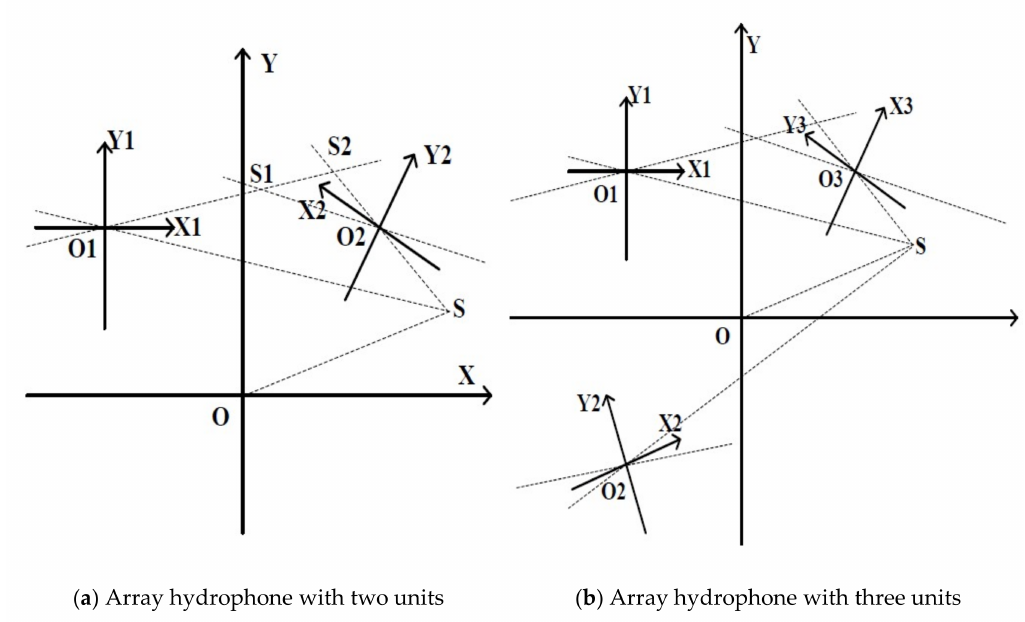
Figure 4. The positioning results of the array MEMS vector hydrophone.